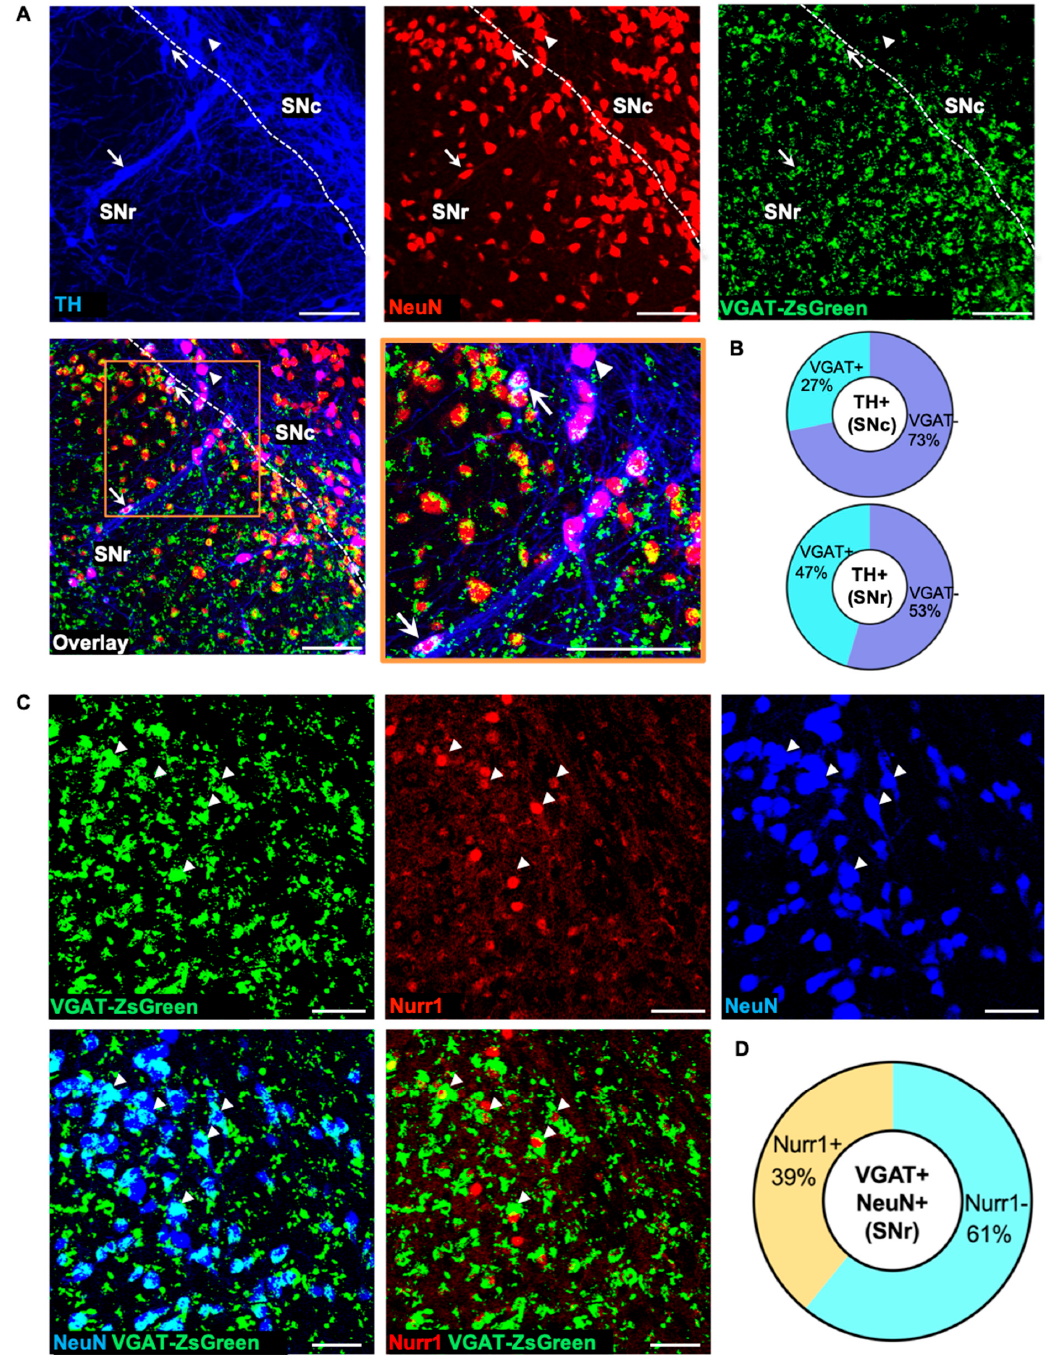
Figure 5. GABAergic neurons expressing Nurr1 in the SNr revealed a reserve pool recruitable to acquire a DAergic phenotype. ( A ) Representative confocal images of the SN of adult (P60) vesicular GABA transporter (VGAT)-ZsGreen mice display the distribution of TH+/VGAT+ (arrow) and TH+/VGAT- (arrowhead) neurons. Scale bars = 100 μ m. ( B ) Quantification of IHC preparations shown in A indicate that 26.7 ± 3.9 % of SNc TH+ neurons and 46.8 ± 4.3% of SNr TH+ neurons express VGAT. ( C ) Confocal images of representative SNr sections show VGAT+/Nurr1+/NeuN+ colocalization (arrowheads). Scale bars = 100 μ m. ( D ) Quantification of IHC preparations shown in C indicate that 38.8 ± 2.2 % of SNr VGAT+ neurons express Nurr1.